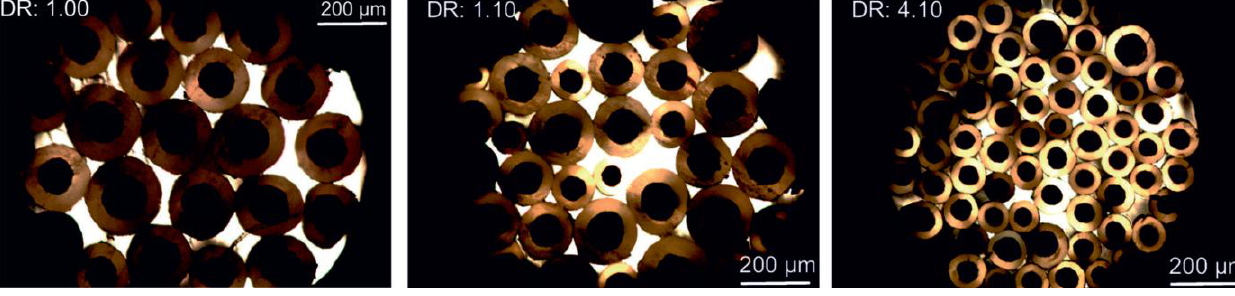
Table 4. Values for orientation factors of α and β phase. Standard deviations σ DR